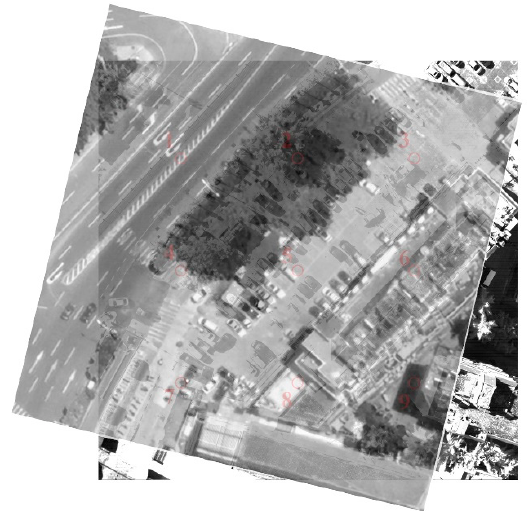
Figure 13. Effect of heterogeneous image registration.